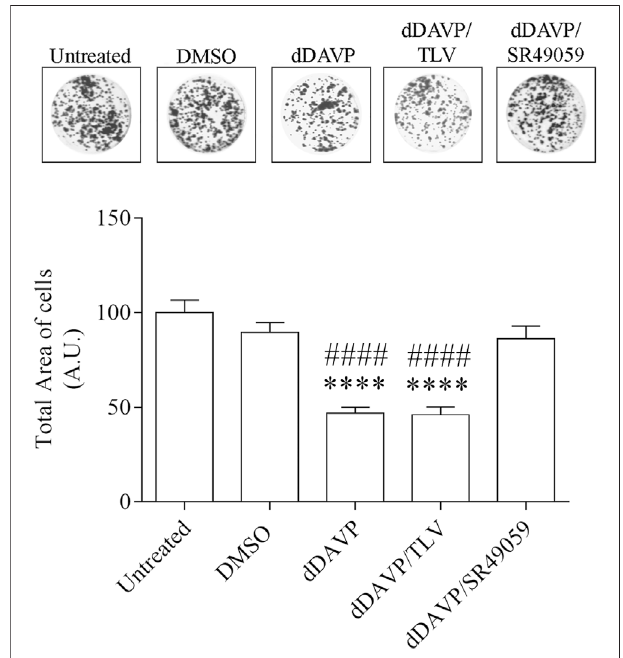
FIGURE 8 | Effect of Vasopressin receptors on cell growth. Cells were left under basal conditions or treated as described in the methods section, stained with 0.2% Coomassie Blue solution, and the total area of the growth cellswasmeasured usingMetamorph software. Compared tountreated cells, treatment with dDAVP signi fi cantly decreased the cell total growth area. A similar effect was observed when cells were treated with 100 nM dDAVP and 100 nM tolvaptan for 72 h. Incubation with 100 nM SR49059 abolished theeffectofdDAVPoncellgrowth.Dataarepresentedasmeans±S.E.M.of6 independent experiments and analyzed by one-way ANOVA followed by Dunnett ’ s Multiple Comparison test (**** p < 0.0001 vs. untreated; #### p < 0.0001 vs.